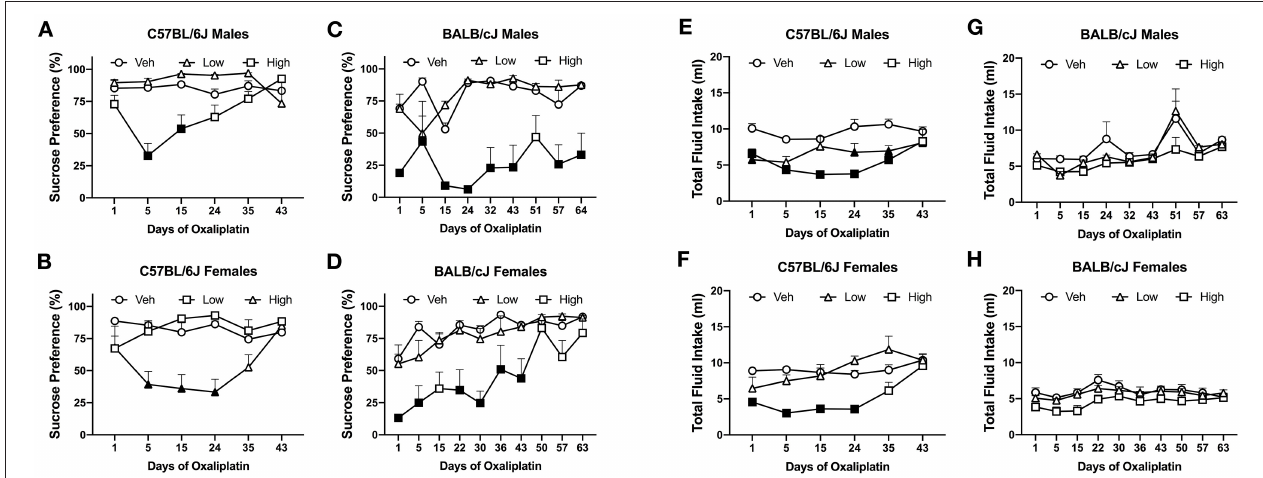
FIGURE 7 | Differential pattern of 3% sucrose solution preference among oxaliplatin-treated animals. Preference was tested in a two-bottle choice test in C57BL/6J males ( n = 4–10/group) (A) , C57BL/6J females ( n = 4–10/group) (B) , BALB/cJ males ( n = 4–6/group) (C) , and BALB/cJ females ( n = 10/group) (D) . The total fluid intake is summarized in C57BL/6J males ( n = 4–10/group) (E) , C57BL/6J females ( n = 4–10/group) (F) , BALB/cJ males ( n = 4–6/group) (G) , and BALB/cJ females ( n = 10/group) (H) . Values are expressed as mean ± SEM. Results were compared using two-way ANOVA (Treatment, Time as RM) for each strain and for each sex